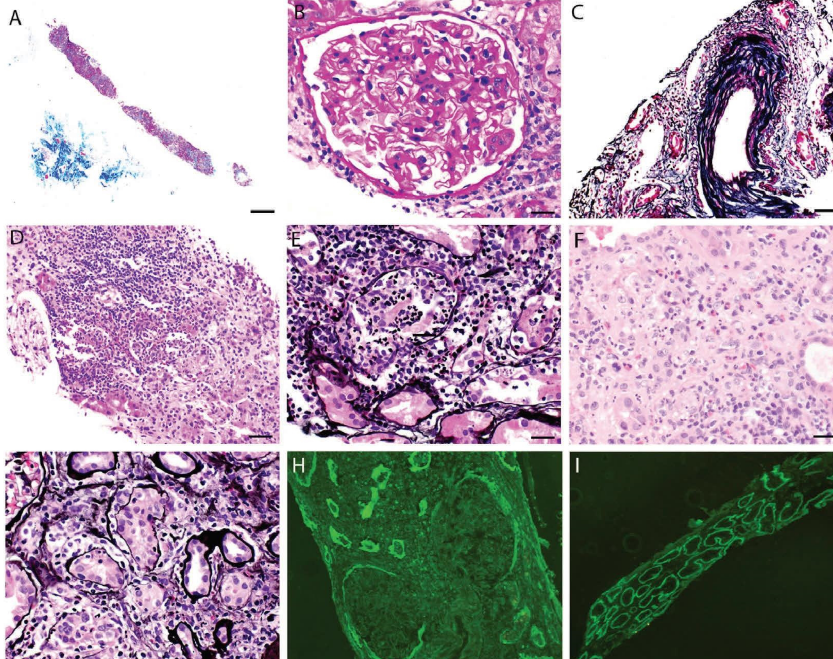
Figure 1: Histopathologic fndings on kidney biopsy. (a) Moderate interstitial fbrosis and tubular atrophy throughout cortex (masson trichrome stain, 20x magnifcation, scale bar � 500 μ m). (b) Unremarkable glomerulus (periodic acid Schif stain, 400x magnifcation, scale bar � 20 μ m). (c) Interlobular artery with severe intimal fbrosis (SMMT stain, 400x magnifcation, scale bar � 20 μ m). (d) Neutrophil-rich infltrate within tubulointerstitium (hematoxylin and eosin stain, 200x magnifcation, scale bar � 50 μ m). (e) Neutrophilic tubulitis (jones methenamine silver stain, 600x magnifcation, scale bar � 20 μ m). (f) Mixed interstitial infammation with lymphocytes, plasma cells, eosinophils, histiocytes, and focal neutrophils (hematoxylin and eosin stain, 600x magnifcation, scale bar � 20 μ m). (g) Lymphocytic tubulitis (jones methenamine silver stain, 400x magnifcation, scale bar � 20 μ m). (h) Linear IgG staining along proximal tubular basement membranes (fuorescein-conjugated antihuman IgG stain, 100x magnifcation, scale bar � 100 μ m), with lack of staining along glomerular basement membranes. (i) Linear IgG staining along proximal tubular basement membranes (fuorescein-conjugated antihuman IgG stain, 100x magnifcation, scale bar � 100 μ m).